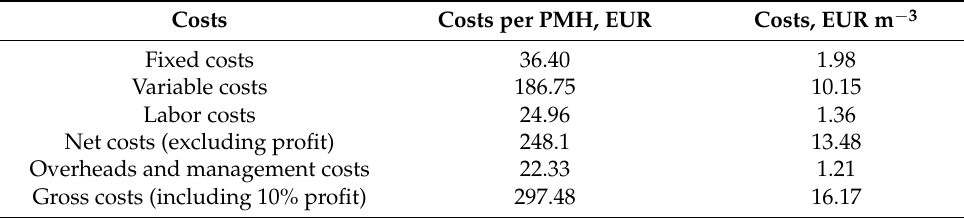
Table 6. Costs characteristics of the studied processor tower